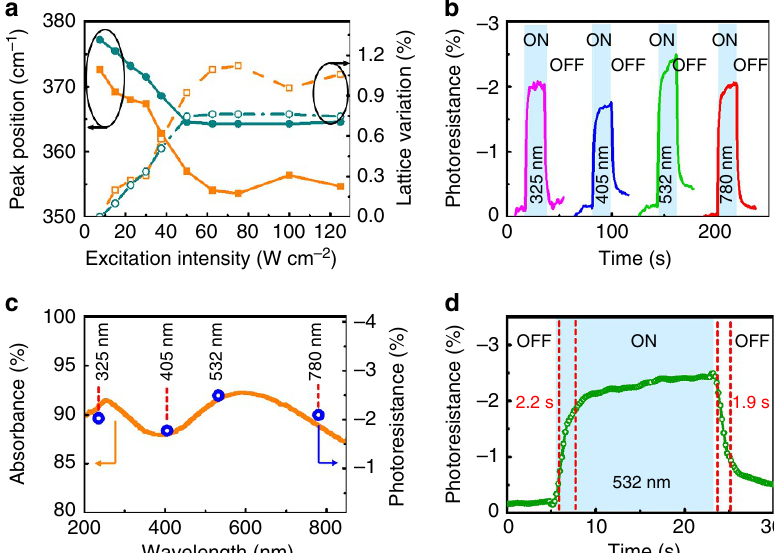
Figure 5 | Photostriction and transient photoresistance of SrRuO 3 thin films. ( a ) The Raman frequency of the A g phonon mode (filled symbols) and in-plane lattice variation (open symbols) as a function of excitation power intensity for single- and multi-domain SrRuO 3 films (that is, grown on DyScO 3 and SrTiO 3 substrates, respectively). ( b ) The wavelength dependence of the photoresistive effect measured in SrRuO 3 thin films on DyScO 3 substrates as a function of time with fixed bias voltage (2V) and excitation power intensity (1.0 (cid:2) 10 5 Wm (cid:3) 2 ). ( c ) The optical absorbance (orange line) and the photoresistance (blue circles) as a function of wavelength for the SrRuO 3 thin films on DyScO 3 substrates. ( d ) The transient photoresistance of SrRuO 3 thin films on DyScO 3 substrates measured at room temperature under 532nm laser illumination (excitation power intensity was 1.0 (cid:2) 10 5 Wm (cid:3) 2 ). The vertical dashed lines indicate the 10 and 90% of the maximum photocurrent.